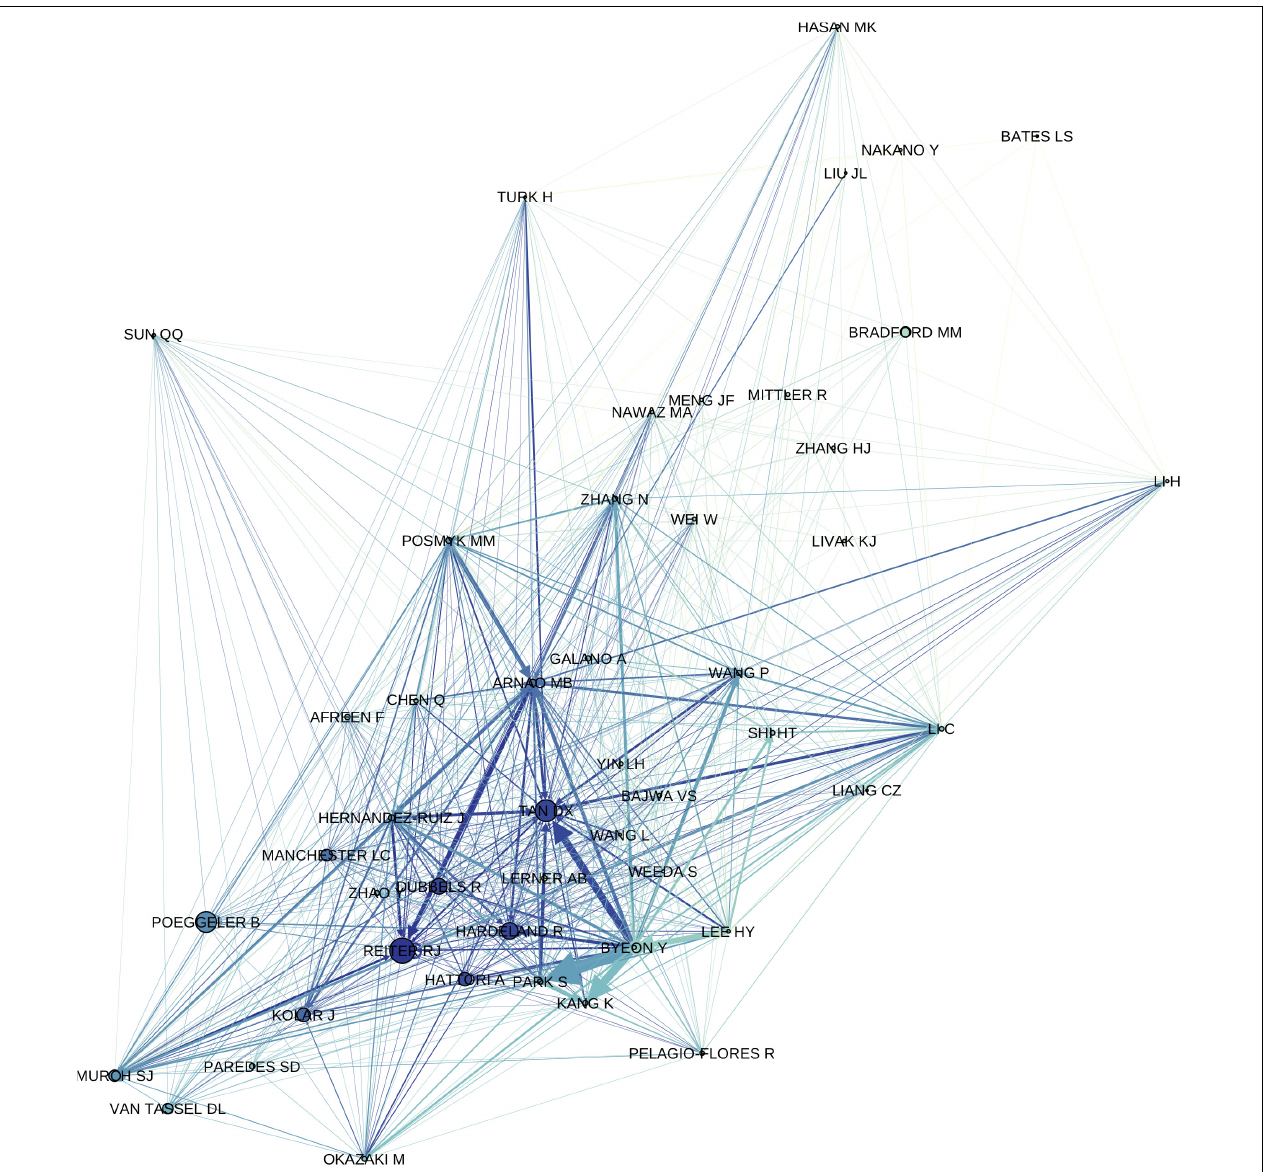
FIGURE 4 | Author correlation network showing relationship between first and last authors of original research articles included in the study and first authors of citing articles, filtered to an in-degree cutoff of > 100. Increasing edge thickness indicates a stronger relationship (higher edge weight), edges are colored to match target node, increasing node size indicates higher page rank (network importance), nodes are colored based on in-degree, i.e., number of authors citing with authors with a greater number of citations being